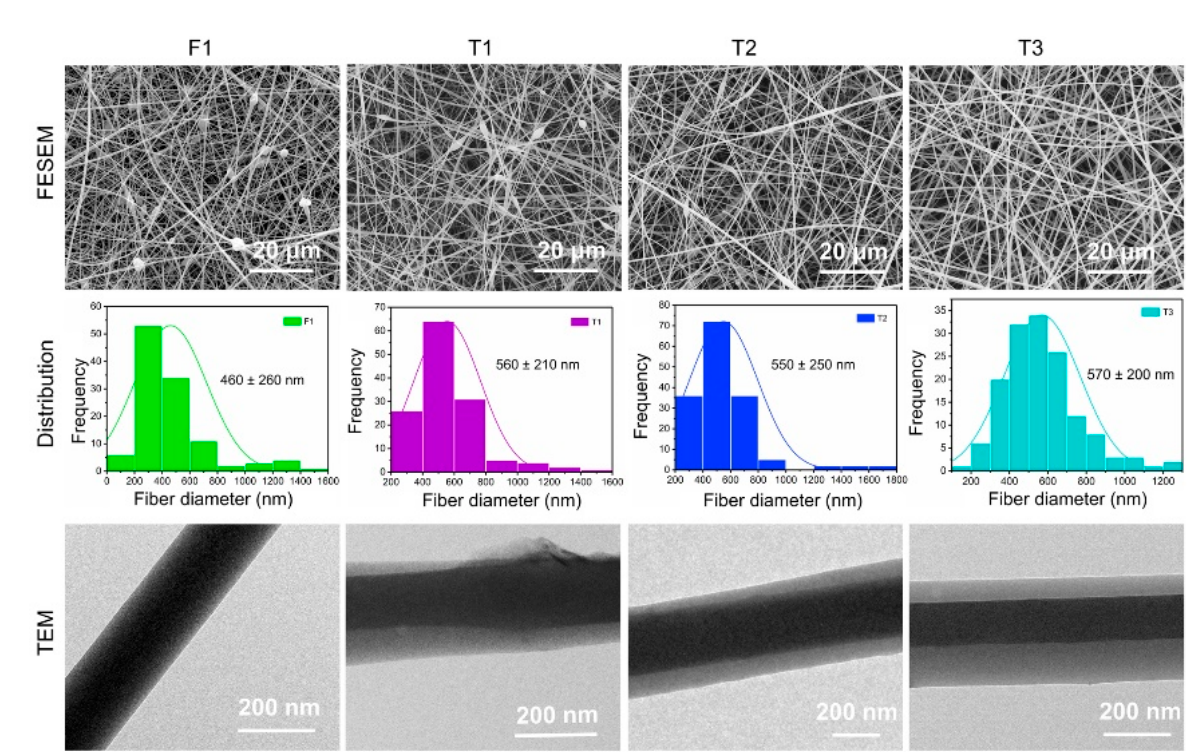
Figure 3. FESEM and TEM images of fiber products and statistical histogram of diameter. Table 2. Details of the thickness in modified triaxial electrospun nanofibers.